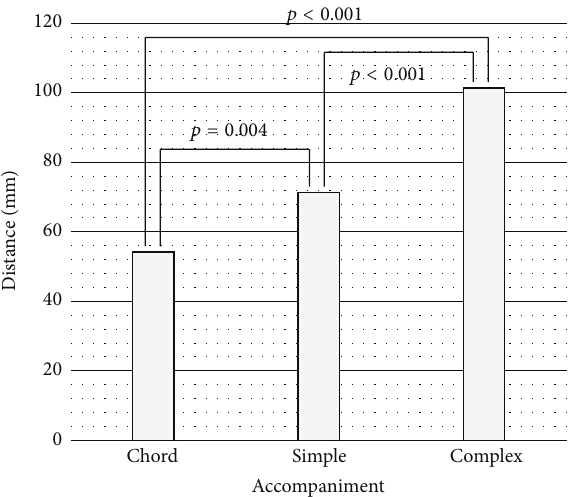
Figure 2: Results of VAS of each accompaniment condition. As the accompaniment became more complex, the subjects regarded the sound of musical pieces as being